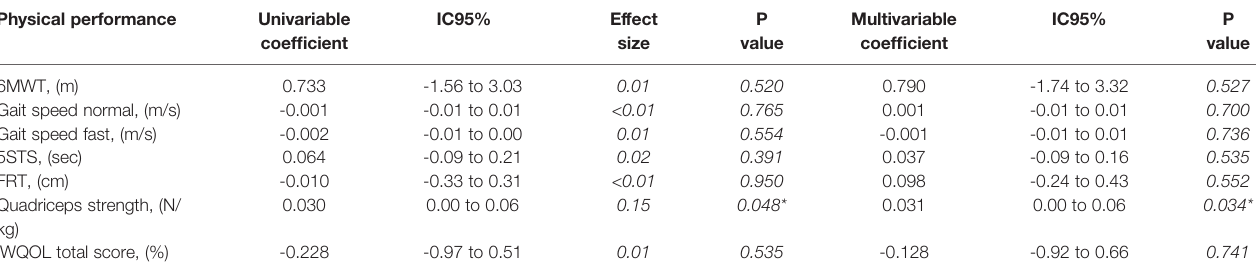
TABLE 3 | Coef fi cients of linear regressions using the change value of respective functional capacity as dependent variable and weight loss as primary exposure factor (univariable) and age, strength difference between pre-post, and baseline level of the respective functional capacity as co-factors (multivariable). Physical